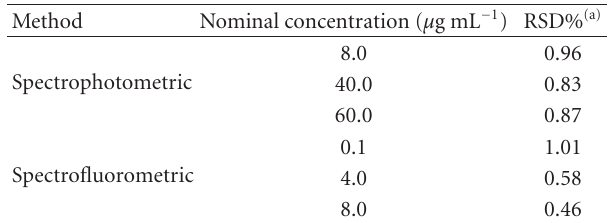
Table 3: The precision of the proposed methods at three concen- tration levels of AMD.